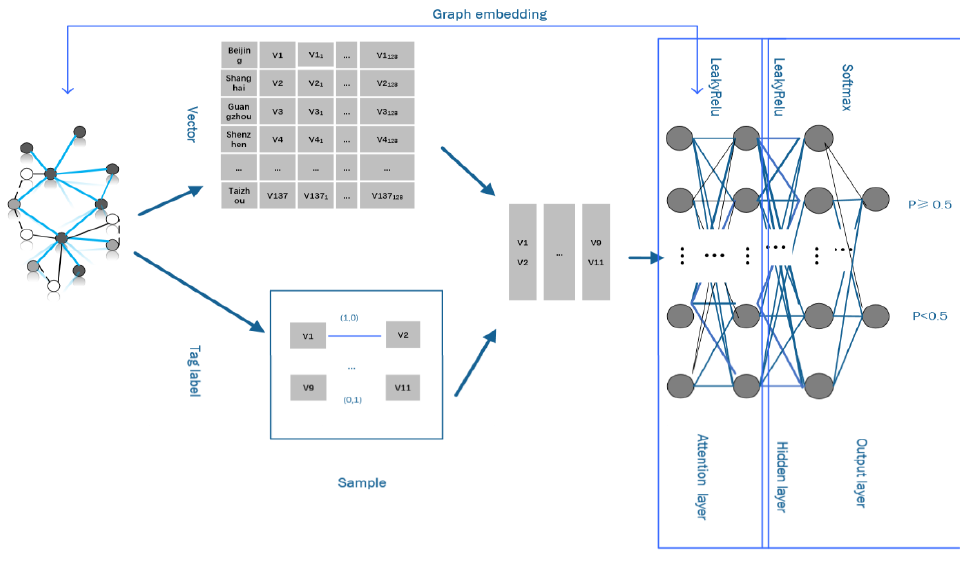
Figure 3. Edge site neighbor completion process.